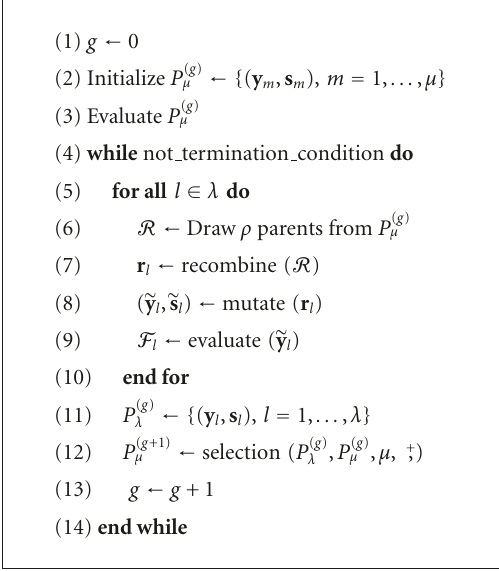
Algorithm 1: ( μ/ρ + , λ